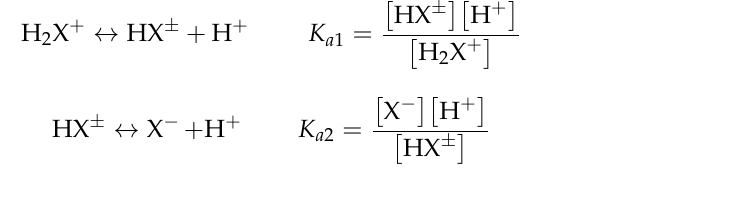
Figure 4. XRPD diffractograms of anhydrous and monohydrate forms of Norfloxacin–resorcinol cocrystal compared to Norfloxacin initial batch and resorcinol.